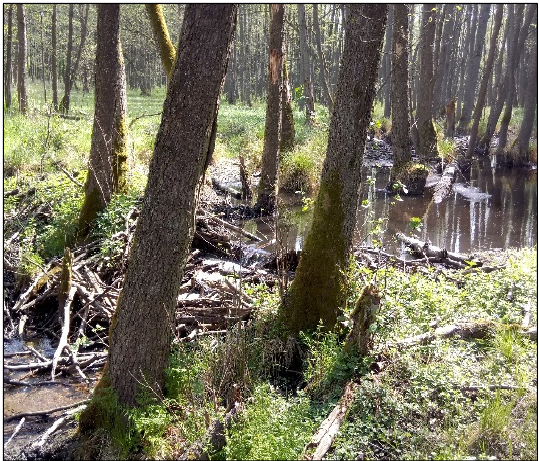
Figure 5. Wetlands—small retention provided by beaver dams, the Lipka Forest District (Photo: A. Krysztofiak ‐ Kaniewska).